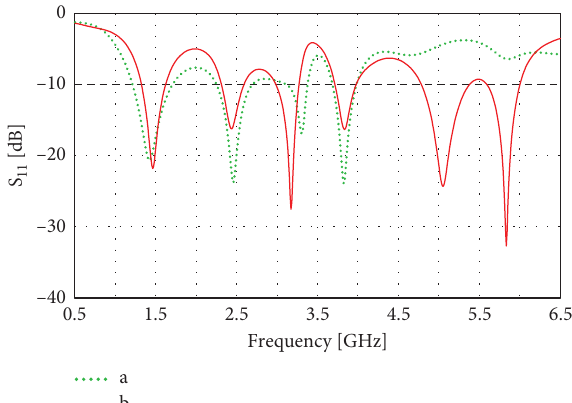
Figure 6: Comparison of the basic model and final model.